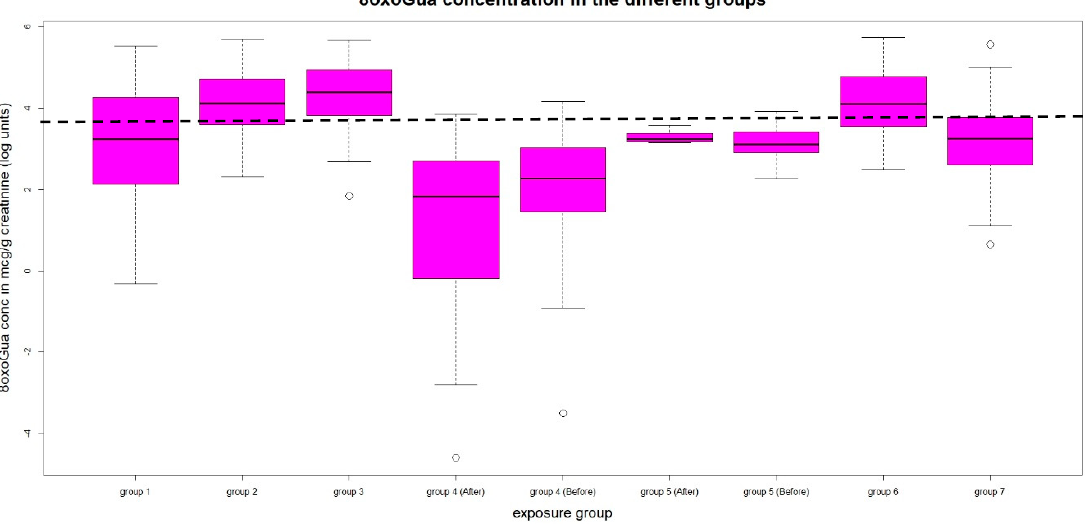
Figure 1. Urinary concentrations of 8-oxoGua.